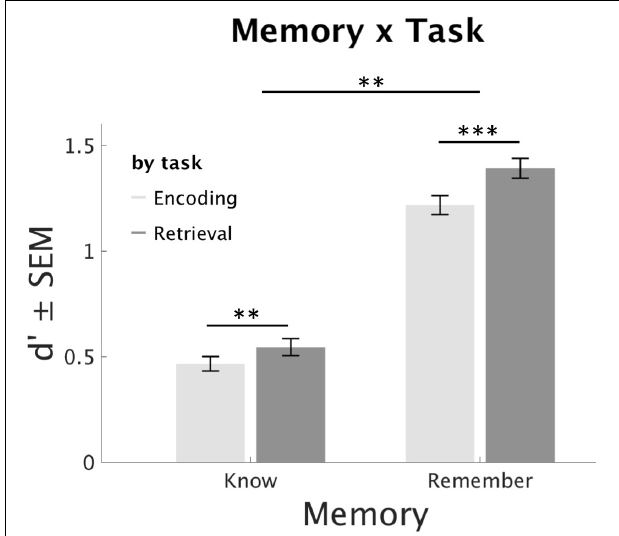
FIGURE 4 | Effects of retrieval practice on type of memory. Retrieval increases both types of recognition memory, but this effect is more pronounced for remember rates. ∗∗∗ p < 0.001, ∗∗ p <